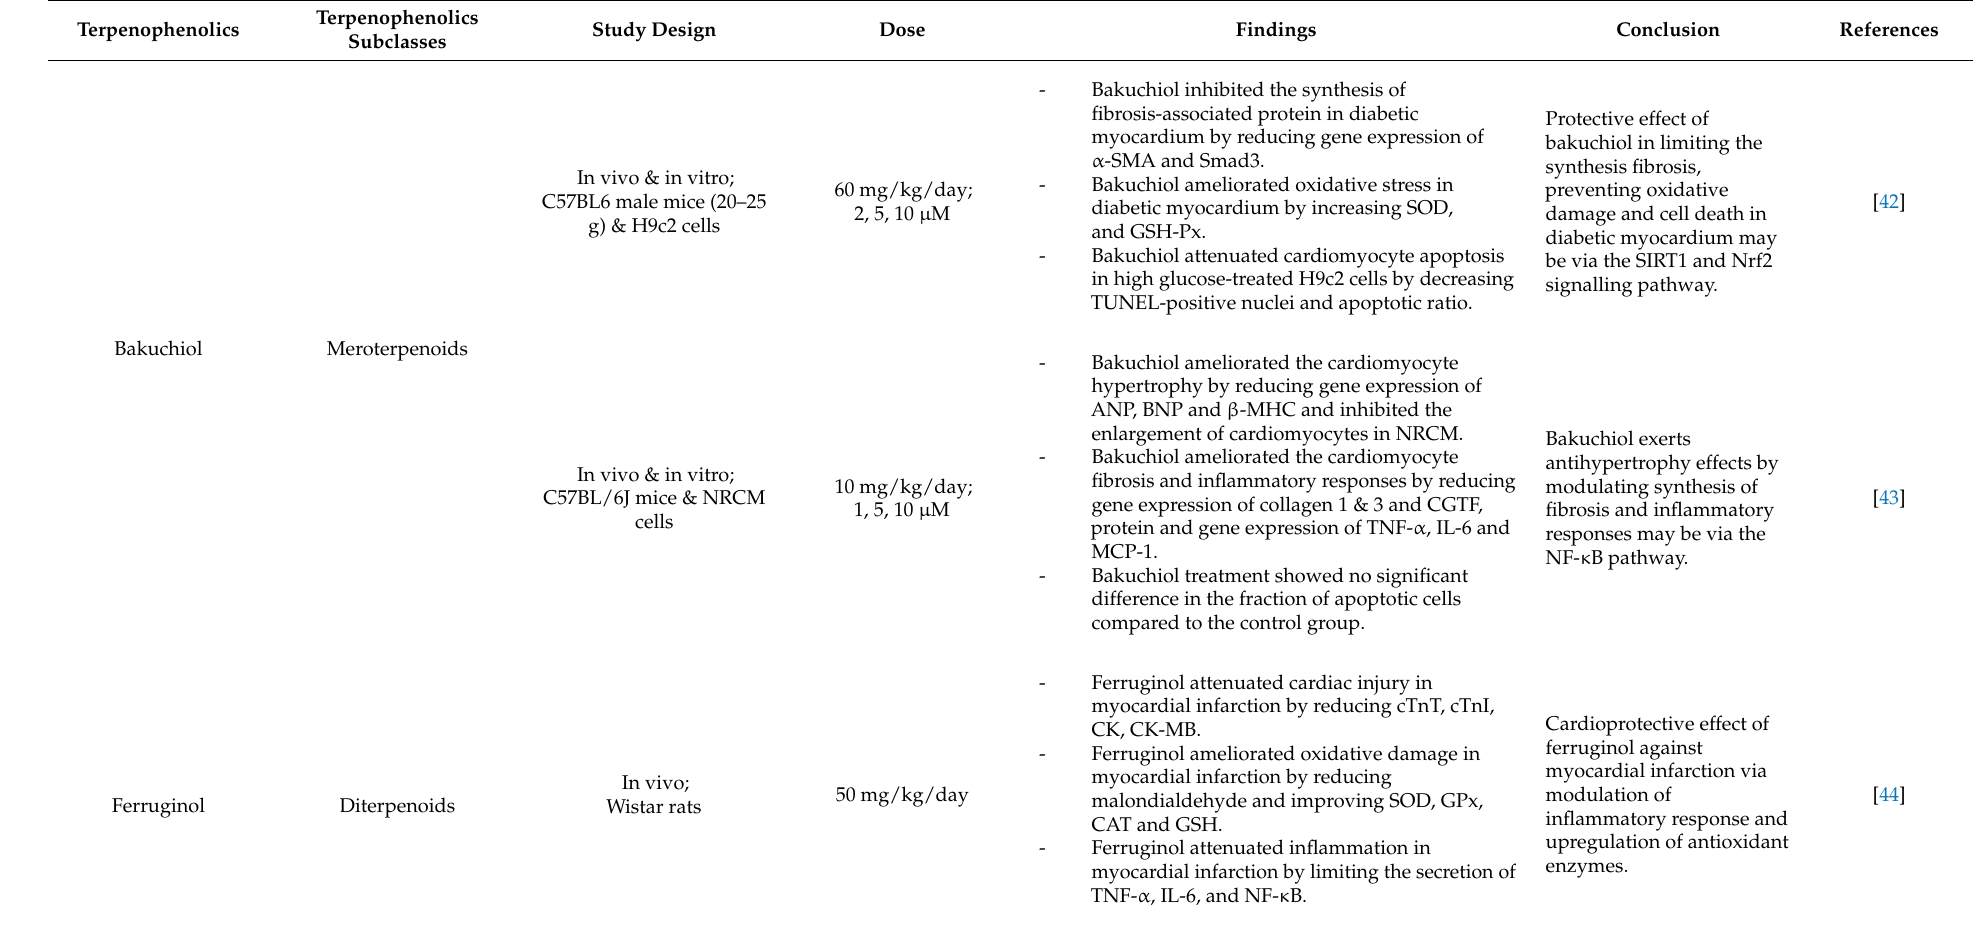
Table 3. Summary of cardioprotective effects exerted by terpenophenolic compounds published between 2017 and